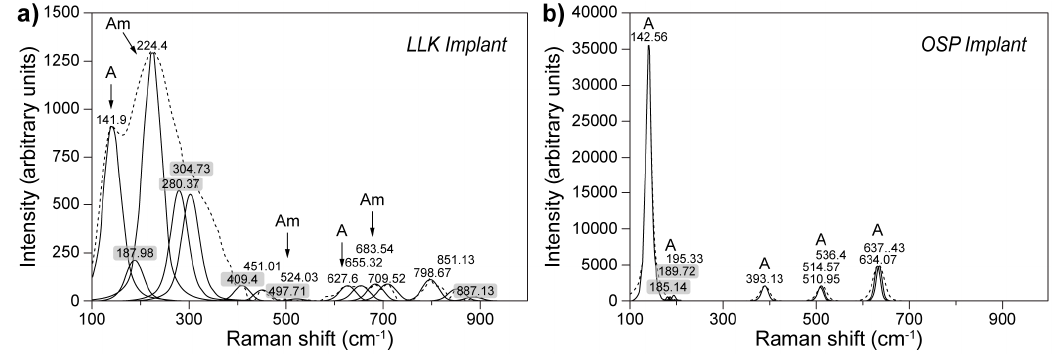
Figure 10. Raman spectra of ( a ) LLK and ( b ) OSP implant. Original spectra are denoted by a dotted line, curve fitting by a solid line. Figure adapted with permission from [69].